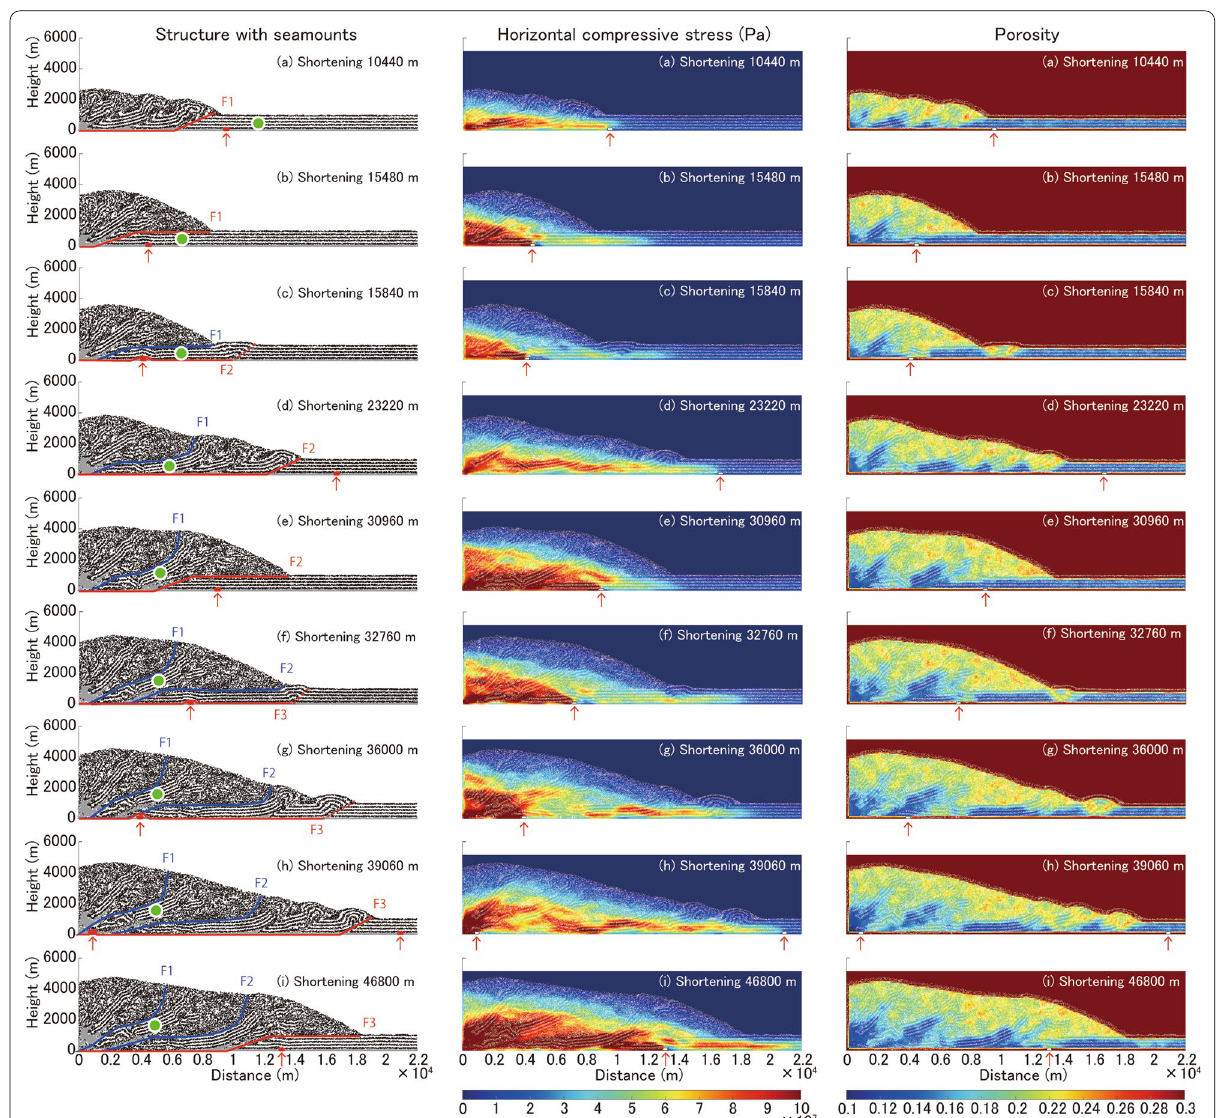
Fig. 3 Simulation results for multiple BTH collisions: geological structure (left), horizontal compressional stress (middle), and porosity (right). The geological structures are overlain on the horizontal stress and porosity as a translucent layer. Thick red lines in the left panels show the most active fault at that time. Thick blue lines in the left panels are the previously active faults. The green symbols on the geological structures (left) mark the locations of monitoring particles, which are monitoring points for the stress state and porosity (Fig. 5). The red arrows indicate the locations of the BTHs